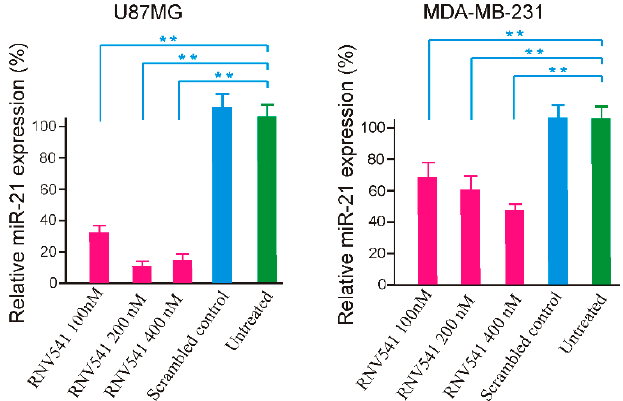
Figure 3. miR-21 cleavage efficacy of RNV541 antimiRzymes on U87MG glioblastoma and MDA-MB-231 breast cancer cells. Cells were transfected with RNV541 at the indicated concentration for 24 h using Lipofectamine 3000. The total miRNAs were then isolated, and miR-21 expression was quantified by performing real-time PCR assay. ** p < 0.01.